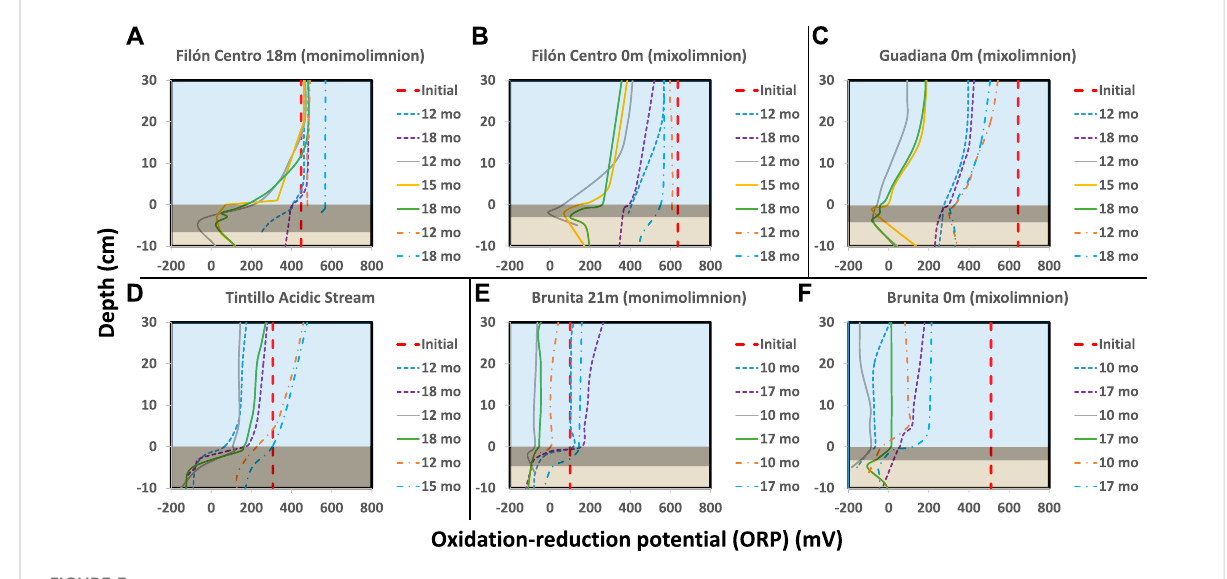
FIGURE 3 ORPevolutionovertimeinthedifferentIC. (A) FC18 m (B) FC0 m (C) GU0 m (D) TIstream (E) BR21 m (F) BR0 m.Thickreddashedlineshows the initial ORP at the beginning of incubation; thin dashed line marks the evolution in untreated columns, solid line in glycerol amended and dash- dotted cool-stored IC. Blue area shows the water column, dark rectangle black sediment (gly-amended column) and brownish the least affected sediment